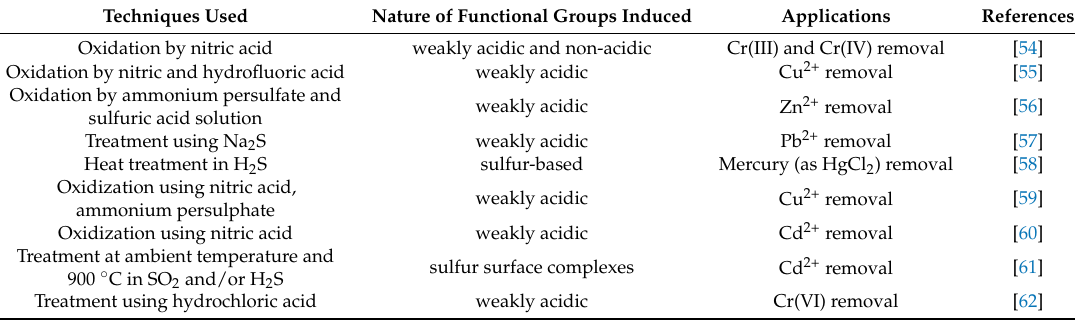
Table 1. Recent research studies on modification of carbon surfaces to generate specific surface functionalities for enhanced removal of metal